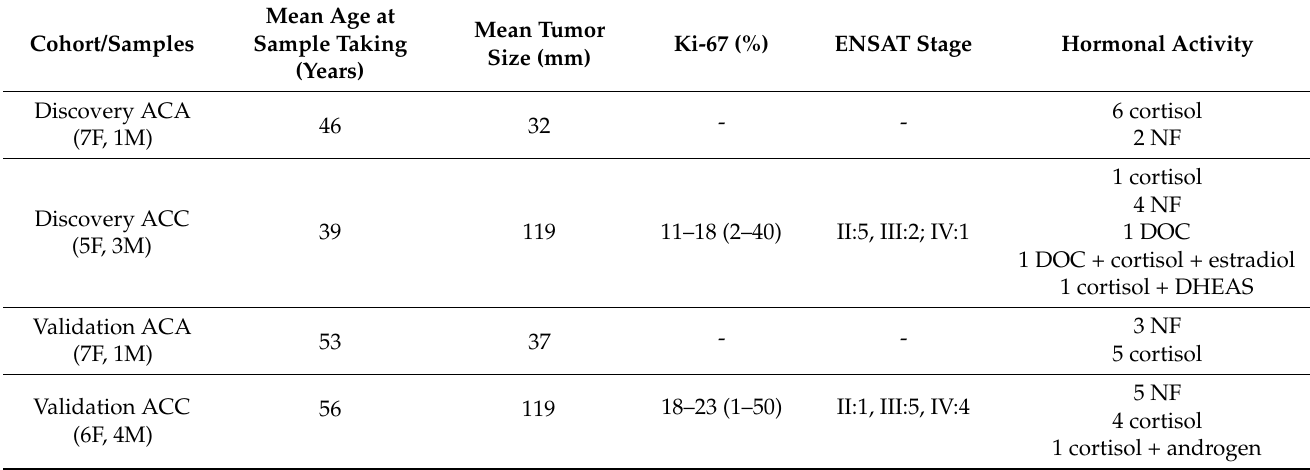
Table 1. Basic characteristics of patients. ACA: adrenocortical adenoma; ACC: